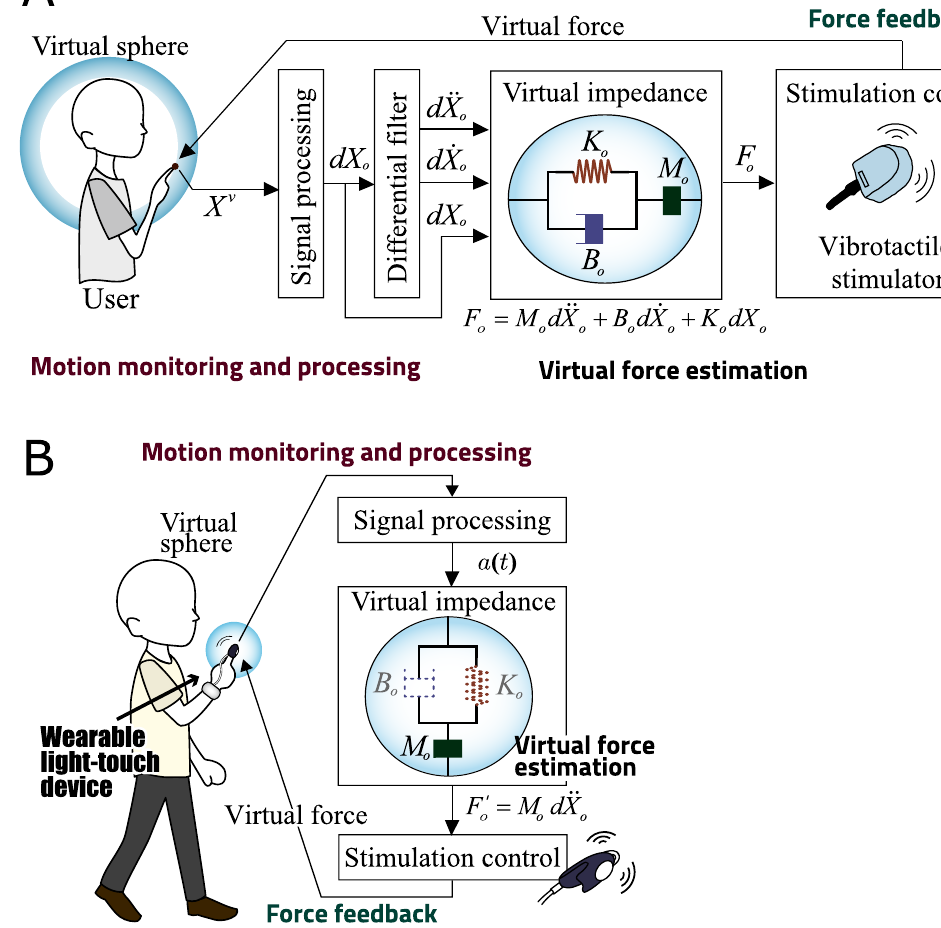
Figure 1. Overview of the proposed virtual light-touch system.The system involves the steps of motion monitoring and processing, virtual force estimation based on non-contact impedance, and force feedback provision to the user via a vibrotactile stimulator based on motion. ( A ) Basic system involving 3D motion capture and non-contact impedance with full parameters. ( B ) Wearable light-touch device with a simple acceleration sensor and a vibrotactile stimulator based on the simplest equation of motion (acceleration